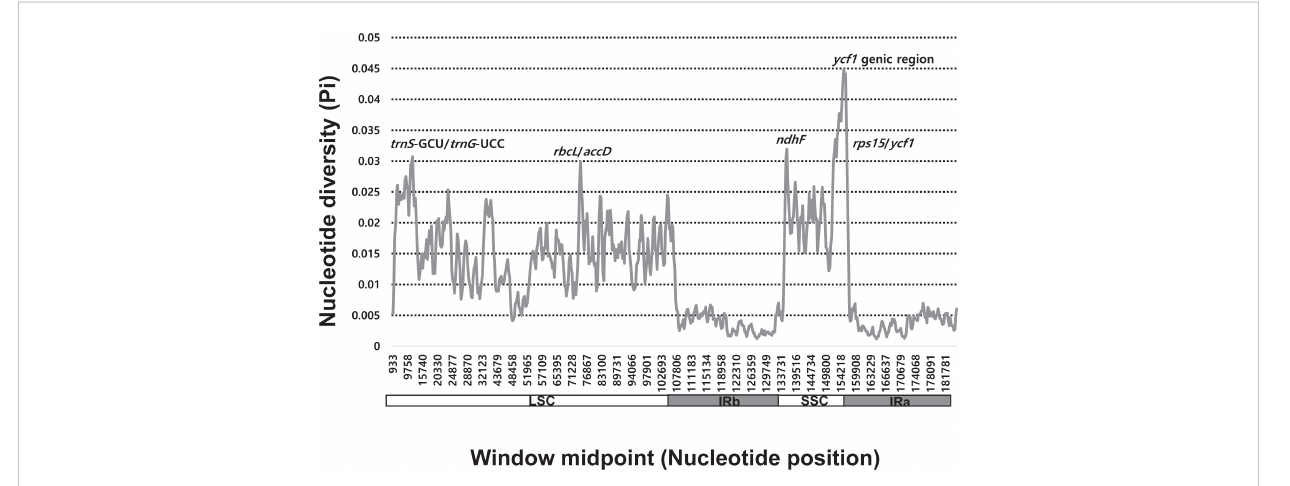
FIGURE 3 Five most variable regions found among the three evolutionary lines of genus Allium